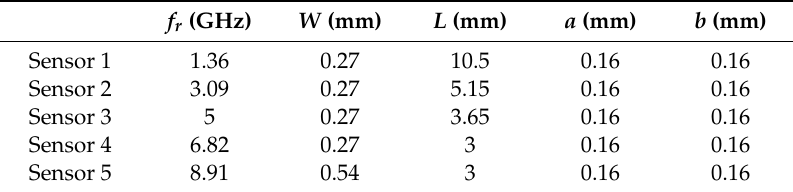
Figure 2. Parametric model of each complementary split ring resonator (CSRR). Table 1. Dimensions of the designed CSRRs.